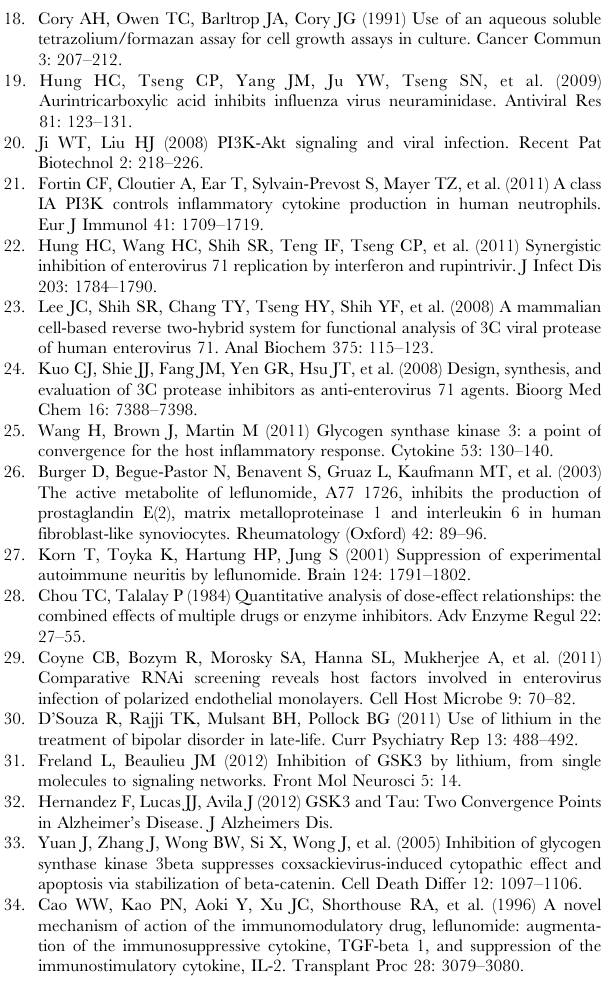
Figure S1 The cytotoxicity effect of PI3K (LY294002 and wortmannin), P38 MAPK (SB203580) (A), GSK3 b (LiCl (B) and AR-A014418(C)) and A771726 (C) in this study. Cytotoxicity assays were performed as described in the materials and methods section. Data are displayed as mean 6 s.e.m. of triplicate measurements and are representative of three indepen- dent experiments. (TIF) Figure S2 The effects of the combination of LiCl and A771726 on virus yield (A), IL-6 expression levels (B) and viral protein synthesis (C) in EV-A71-infected SF268 cells. SF268 cells were infected with EV-A71 (moi 0.5), and various concentrations of LiCl and A771726 were added to the infected cells for 48 h after infection. Assays were performed as described in the materials and methods section. Data are the mean 6 s.e.m. from at least three parallel measurements per experiment. Symbol indicates significant differences as determined by one way